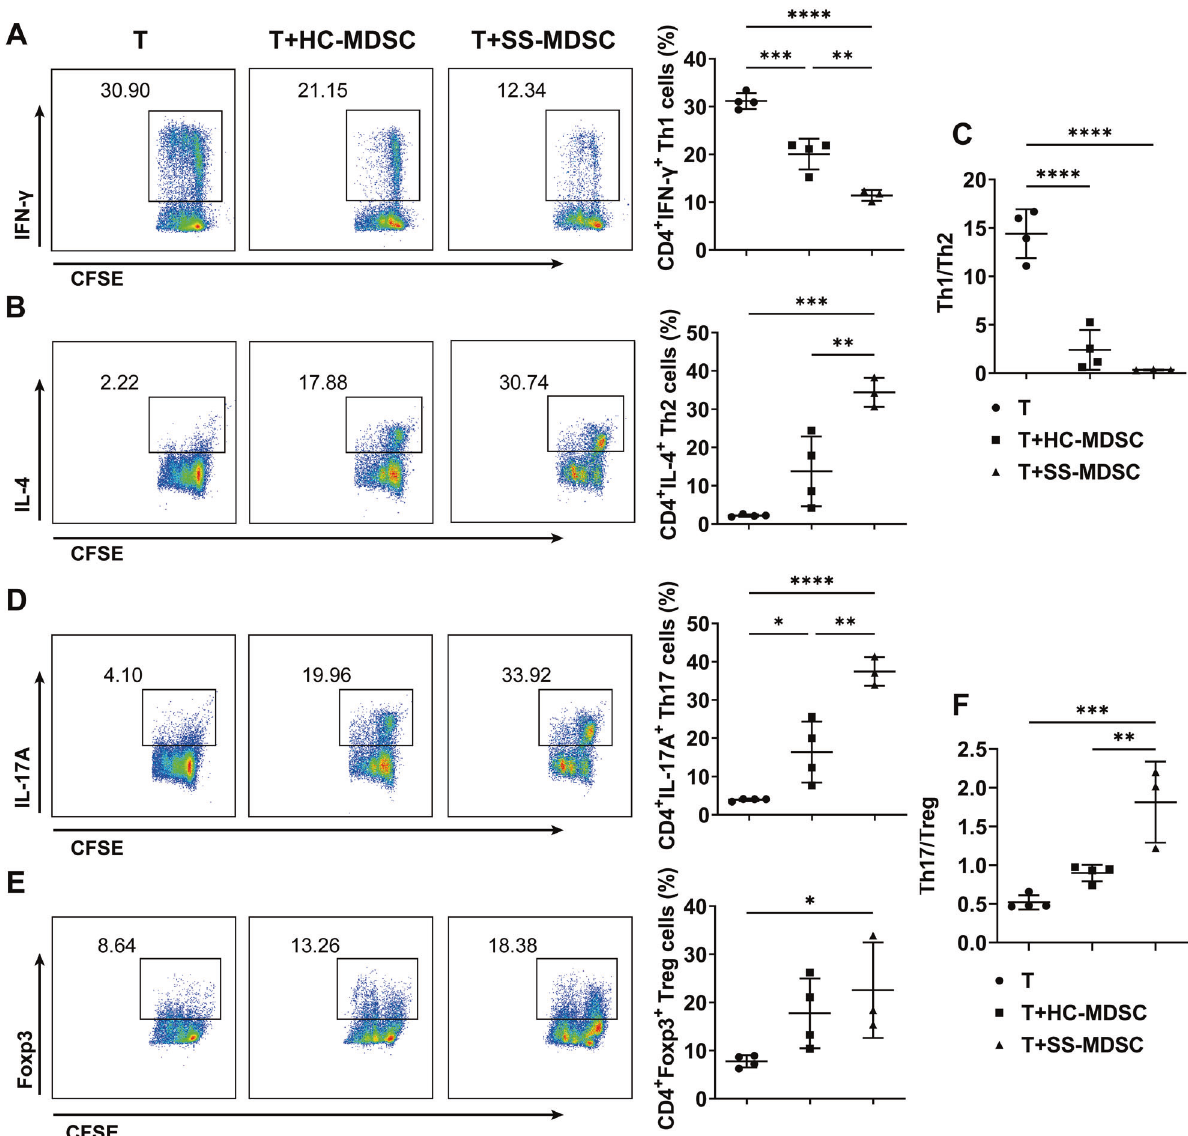
Fig. 2 MDSCs disturbed the balances of Th1/Th2 and Th17/Treg cell subsets in SS patients. Peripheral monocytes from HC and SS patients were induced into MDSCs, which were co-cultured with CFSE-labeled CD4 + T cells for 72 h. Representative fl ow cytometric analysis and percentages of CD4 + T cell subsets were shown. A CD4 + IFN- γ + Th1 cells, B CD4 + IL-4 + Th2 cells, C the ratio of Th1/Th2, D CD4 + IL-17A + Th17 cells, E CD4 + Foxp3 + Treg cells and F the ratio of Th17/Treg. All the data are representative of two independent experiments. n = 4, * p < 0.05, ** p < 0.01, *** p < 0.001, **** p <